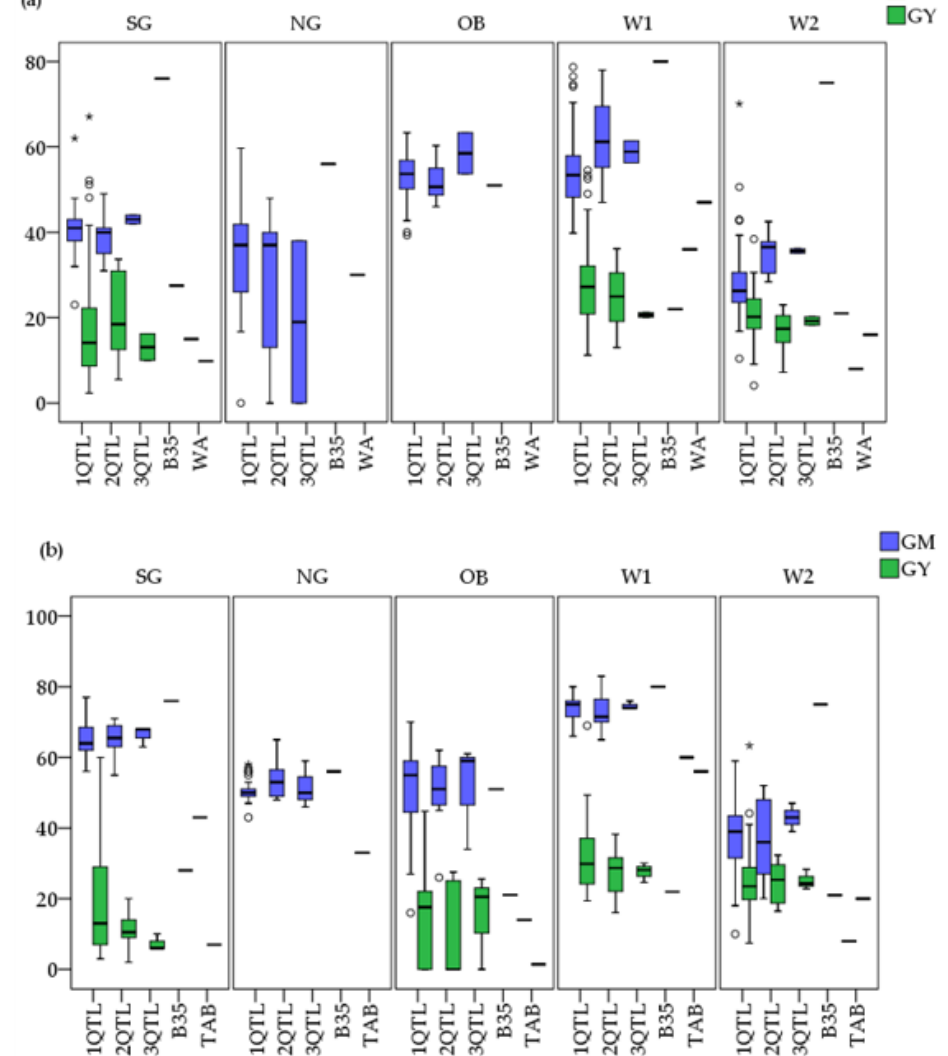
Figure 4. Percentage greenness at maturity (GM) and grain yield (GY) of the ( a ) 46 and ( b ) 52 stay- green introgression lines with one, two, or three QTLs, and their parents ‘Tabat’ (TAB), ‘Wad Ahmed’ (WA), and B35 in five environments, South Gedaref (SG), North Gedaref (NG), El Obaied (OB), and Khartoum irrigated (W1) and drought (W2).